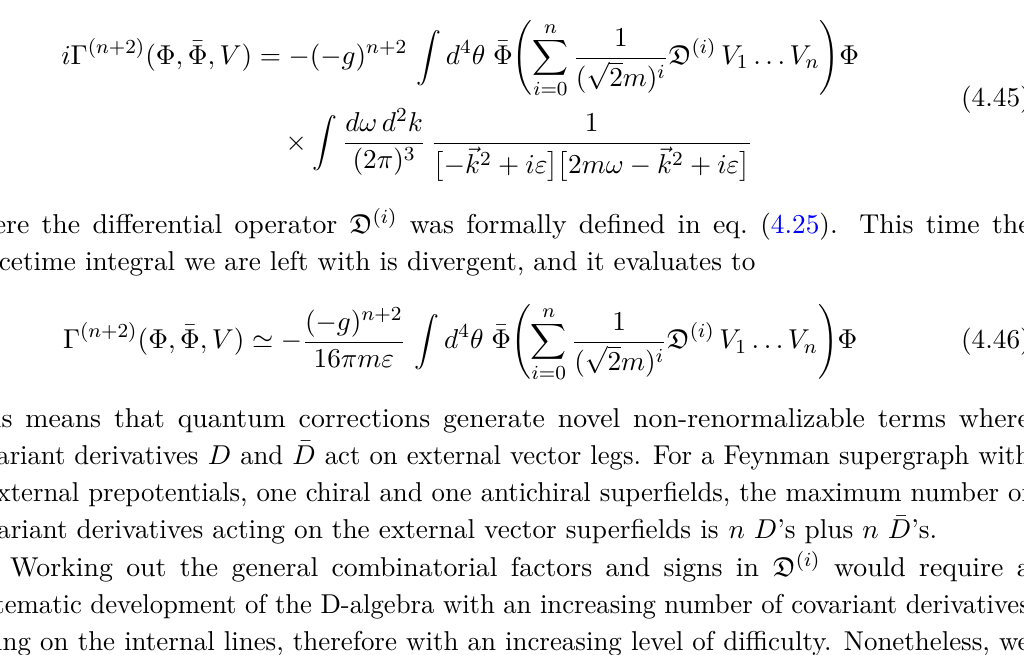
(Ω ) and k ≡ ( ω,~k ) j ≡ j , ~p j